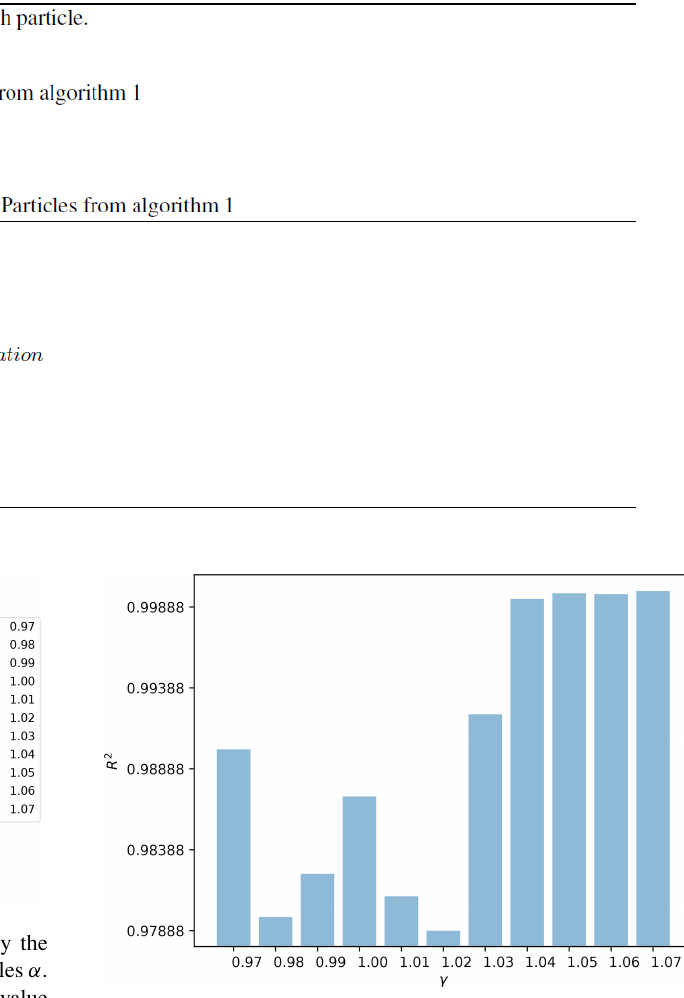
Figure 5. The linear regression coefficients R 2 for each γ used and the data points from Fig. 4.